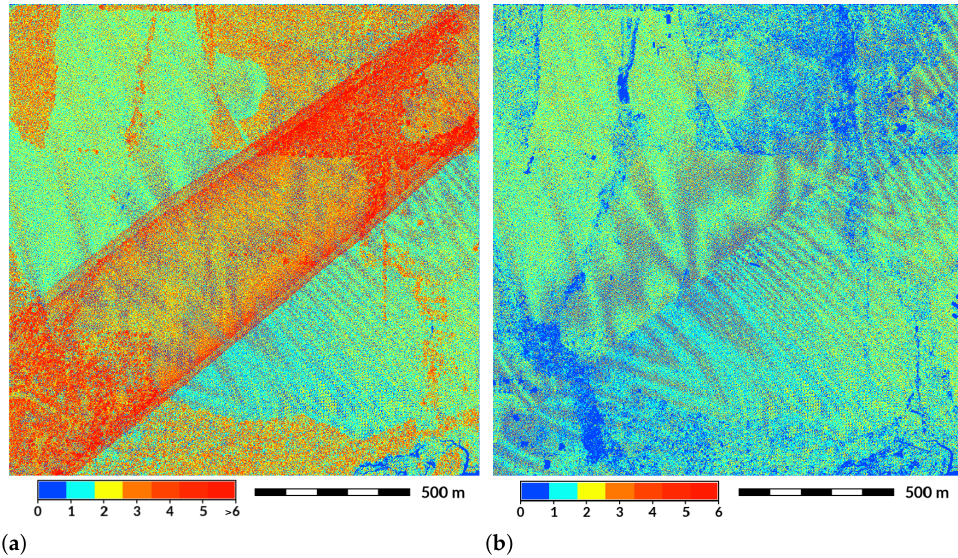
Figure 7. Swath overlap as the main source of variation in point density. ( a ) Overlap of two swaths in red and orange around the image diagonal. ( b ) An abrupt change in the pattern that follows a straight line (close to image diagonal) marks the transition between swaths and removed swath overlap in classified ground points. Additionally, both figures showed a Moiré effect in the point density. Figures show the number of points per grid cell at 1 m resolution. Dataset: Wake County 2013